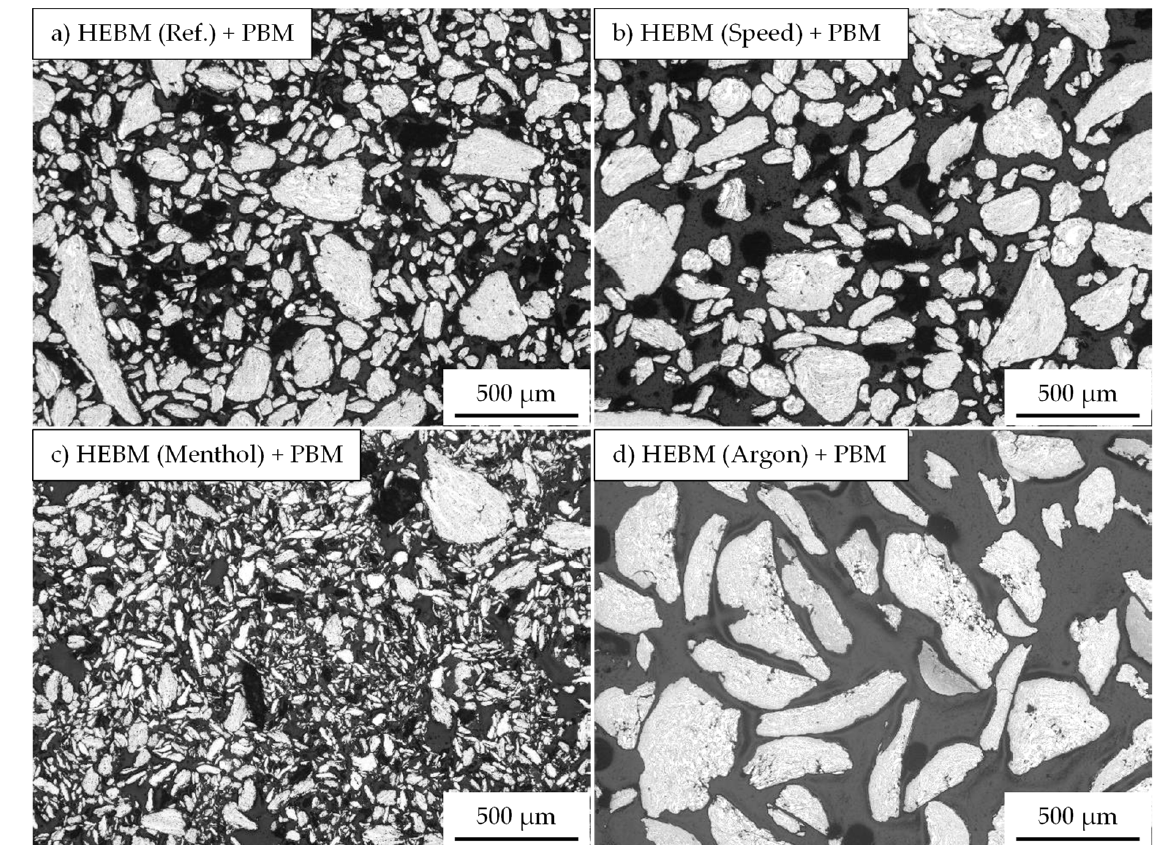
Figure 7. Light microscopic images of the HEBM composite powder: ( a ) Reference, ( b ) variation of milling speed (Program1), ( c ) milled with menthol (Program2), and ( d ) milled in argon atmosphere (Program3) after a mechanical post-treatment in a planetary ball mill (PBM).